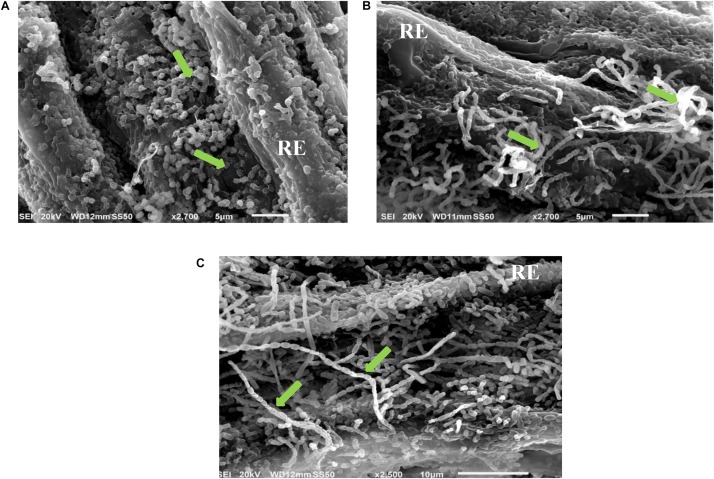
In vitro root colonization of Salicornia bigelovii by selected halotolerant actinobacterial isolates. Scanning electron micrograph of selected actinobacterial (A) auxin-producing isolate #21 (2,700X); (B) polyamine-producing isolate #7 (2,700X); and (C) ACCD-producing isolate #11 (2,500X) colonizing root of S. bigelovii. In (A–C), green arrows represent the chain and/or structure of spores. RE, root epidermis. ACCD, 1-aminocyclopropane-1-carboxylic deaminase.